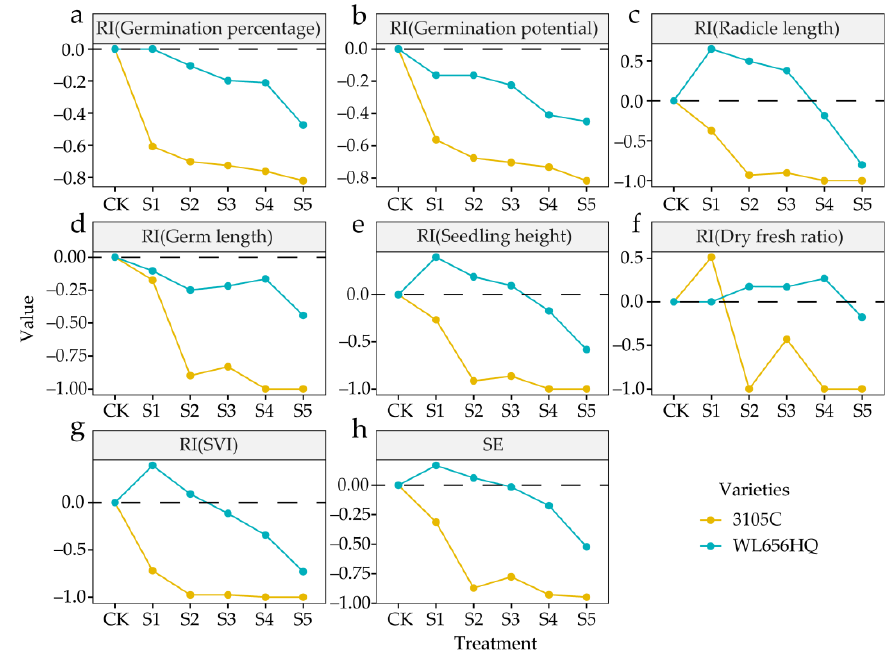
Figure 3. Effects of autotoxicity on comprehensive allelopathic coefficient of alfalfa. RI represents the allelopathic effect index ( a ) germination percentage; ( b ) germination potential; ( c ) radicle length; ( d ) germ length; ( e ) seedling height; ( f ) dry fresh ratio; ( g ) simple vigor index; ( h ) comprehensive allelopathic index of two alfalfa varieties under six concentrations of leaf extracts. When RI ≥ 0, it shows stimulatory effects, and when RI ≤ 0, it shows inhibitory effects. Blue represents WL656HQ. Yellow represents 3105C.